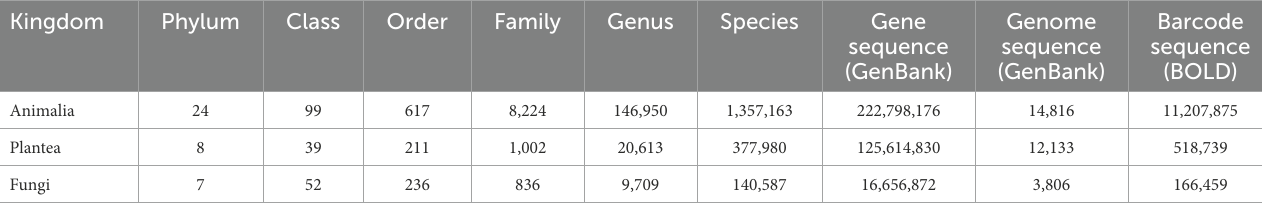
TABLE 1 Number of taxa and genetic data in Animalia, Plantea, and Fungi (September 2022).